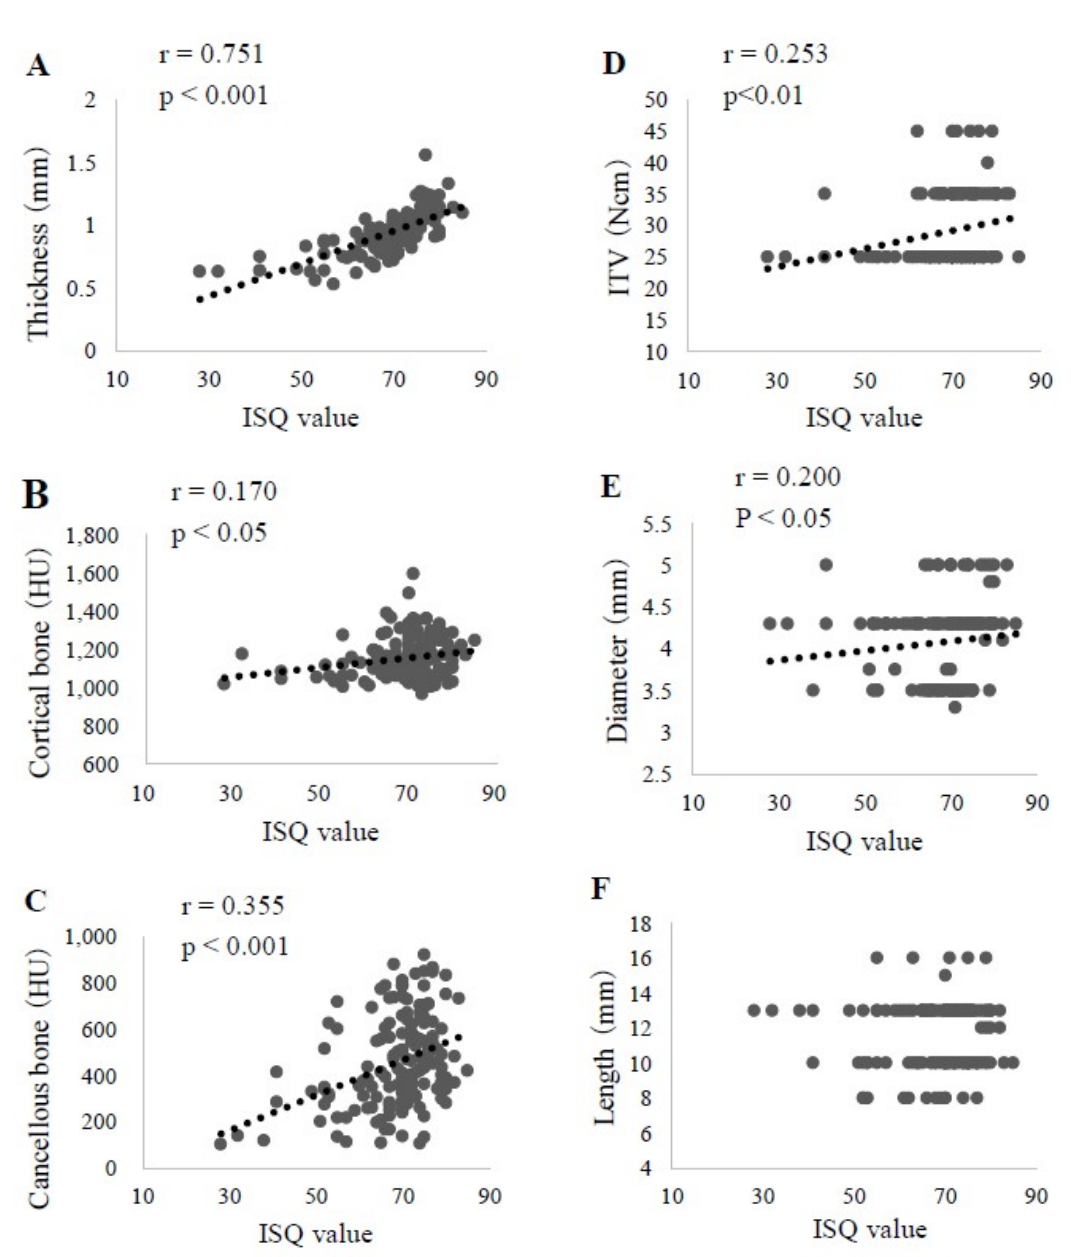
Figure 4. Correlation of each examined factor with the ISQ value in upper jaws (n = 154). A . Cortical bone thickness. B . Cortical bone CT value. C . Cancellous bone CT value. D . ITV. E . Implant diameter. F . Implant length. Table 3. Multiple regression analysis of the upper jaw using the ISQ value as an objective variable.